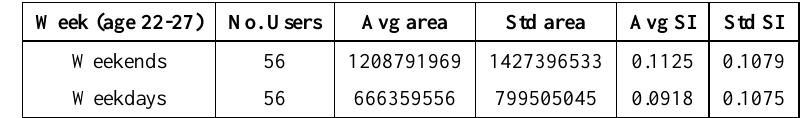
Table 6. Average and standard deviation of area and shape index of users between 22-27 based on days of the week.